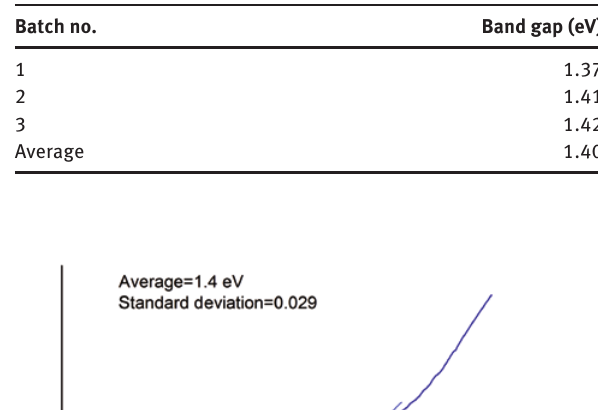
Table 1: Band-gap values of the different batches of the as-synthesized sample.